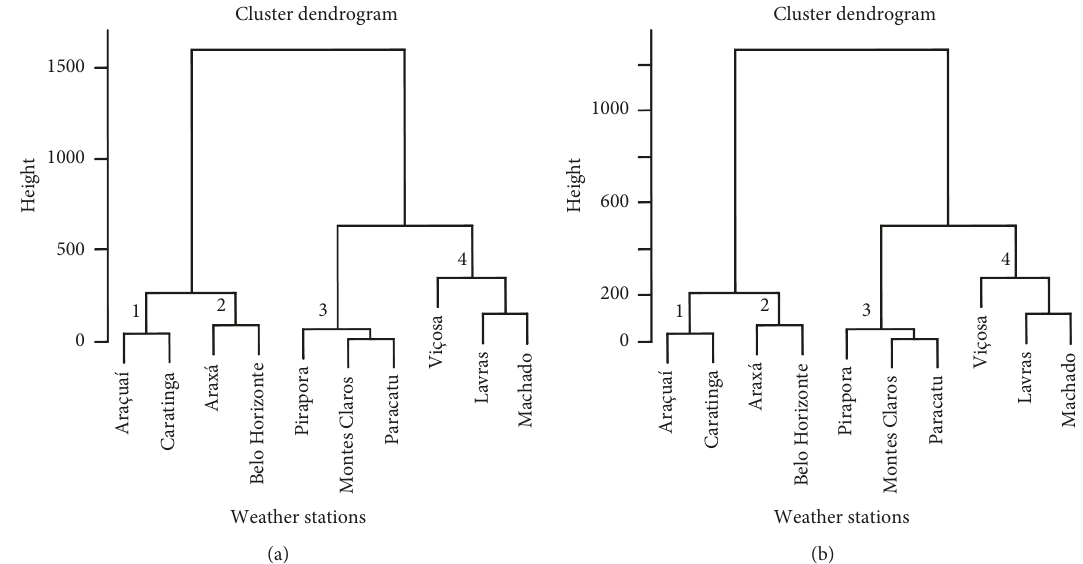
Figure 5: Cluster analysis groups (1, 2, 3, and 4) based on model performance, climate classification ((a) K¨oppen–Geiger’s climate classification and (b) Thornthwaite’s climate classification), and seasonal data variability. Dendrogram was created based on distance between groups only for the models with best